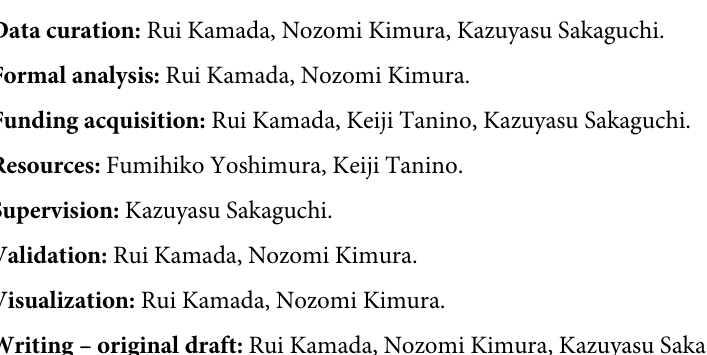
S1 Fig. Quantification of lipid droplets with 10 μ M SL-104 and SL-188. Amount of lipid droplets was quantified by Oil Red O staining. S2 Fig. Imaging of lipid droplets by Monodansylpentane. 3T3-L1 cells were differentiated for 8 days with 15 μ M SL-104. S3 Fig. Inhibitory activity of SL-176 for His-mousePPM1D (1–413) in vitro . Phosphatase activity of His-mousePPM1D (1–413) for p53-derived peptide was measured. S1 Table. Primer